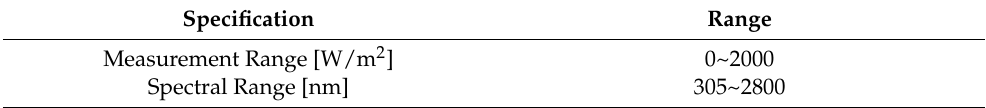
Table 3. Pyrheliometer specification sheet.